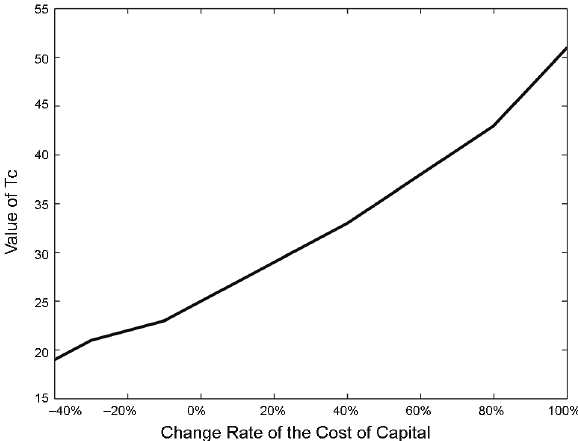
Figure 7. Sensitivity analysis of the discount rate